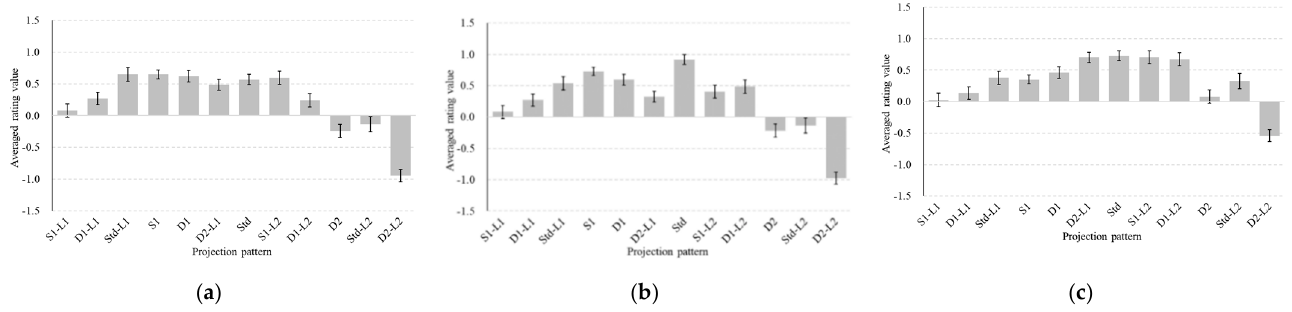
Figure 5. Evaluation results for all observers for each projection pattern in luminance order. ( a ) Faithfulness; ( b ) Preference; ( c ) Depth feeling.